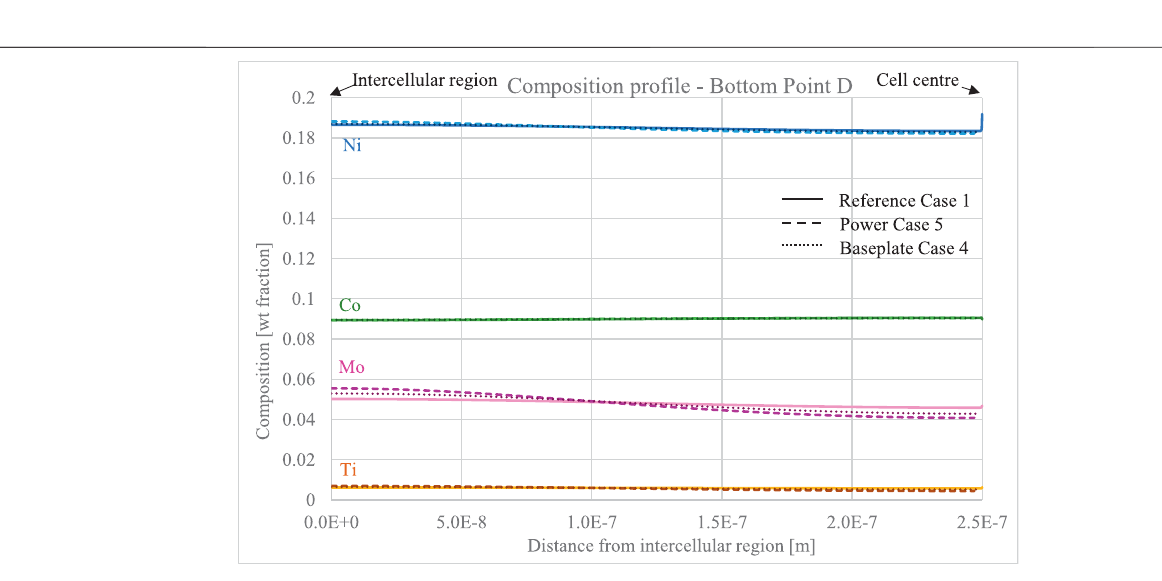
Frontiers in Materials |